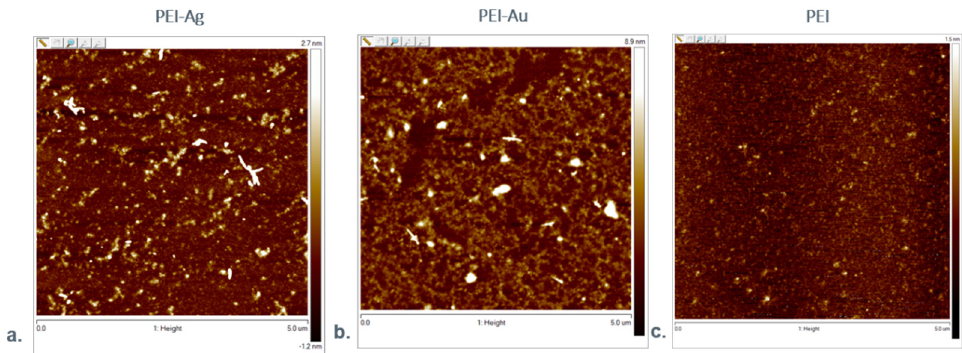
Figure 9. AFM visualization of the layers deposited on the gold mica substrate cover. Key to symbols: ( a ) The surface of the polyethyleneimine membrane with AgNPs incorporating (PEI-Ag); ( b ) the surface of polyethyleneimine membrane with AuNPs incorporating (PEI-Au); ( c ) The surface of the polyethyleneimine membrane.